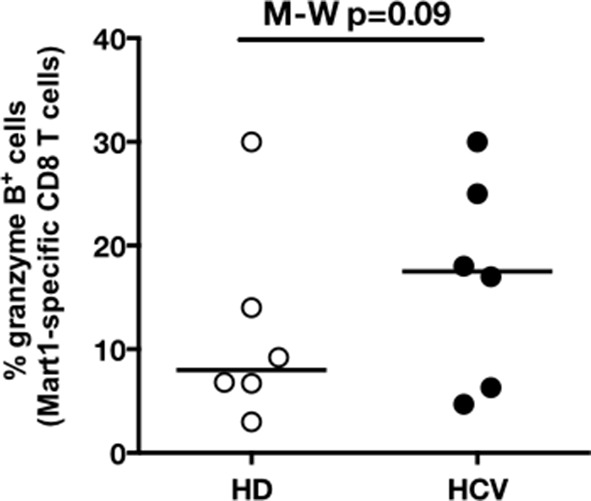
Baseline proportions of granzyme B-expressing cells in cHCV patients and HD.Percentages of cells expressing granzyme-B intracellularly at baseline within Mart1-specific CD8+ T cell population (without peptide stimulation) in HD and cHCV patients.